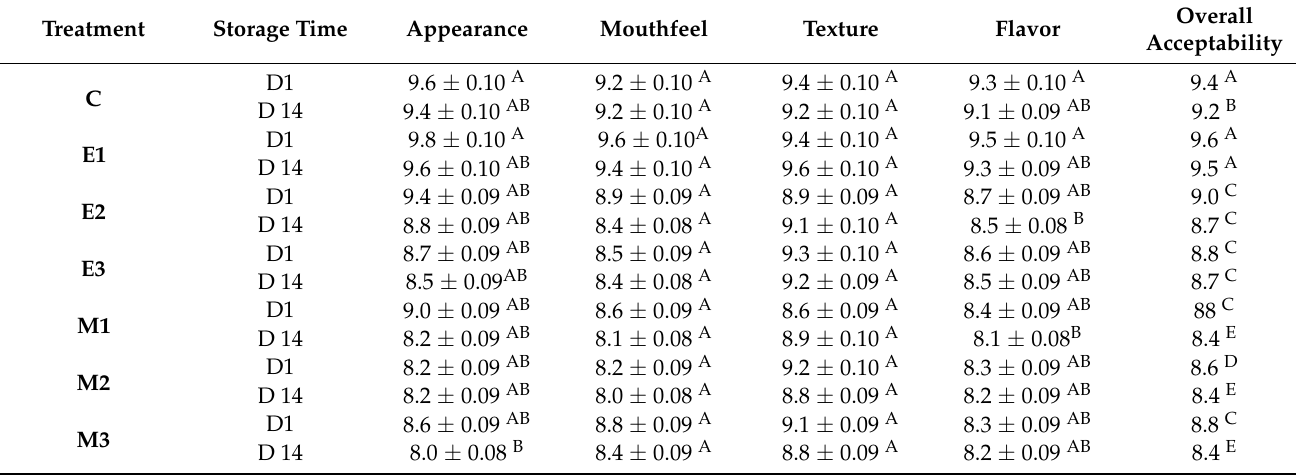
Table 2. The average scores for sensory evaluation of plain and fortified yogurt with Eucalyptus and Myrrh oil. Treatment Storage Time Appearance Mouthfeel Texture Flavor